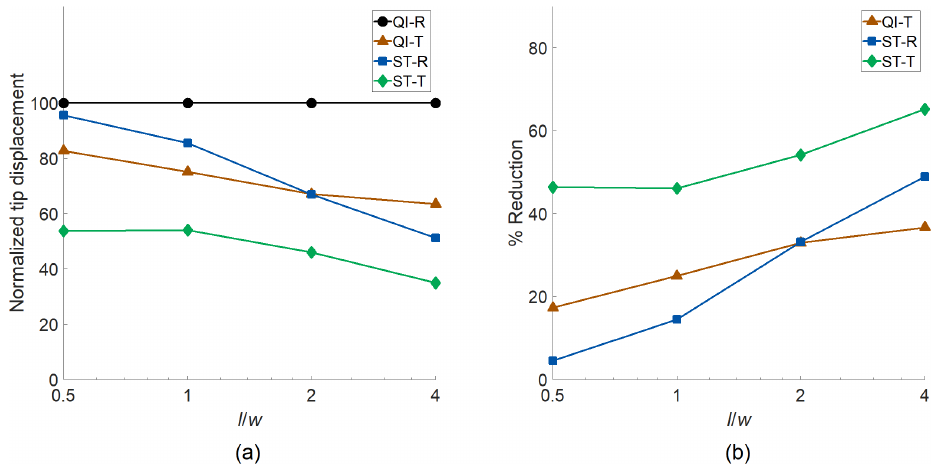
Figure 6. The influences of aspect ratio and design strategy on ( a ) the normalized tip displacements of cantilever plates under shear load and ( b ) displacement reduction percentage compared to the quasi-isotropic rectangular plates.